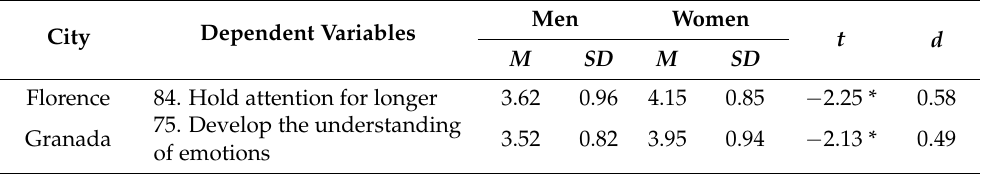
Table 7. Significant differences in the benefits and uses of apps as a function of sex.